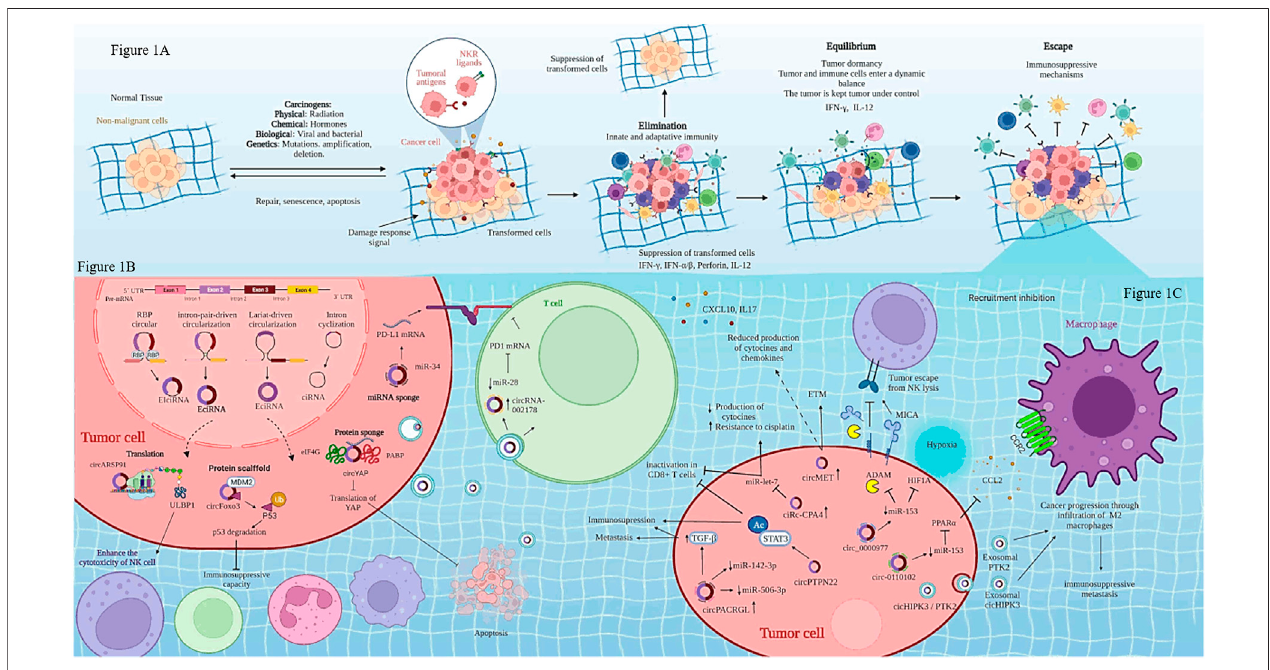
FIGURE 1 | Biogenesis of circRNAs and regulation of immune cells in cancer. (A) shows cancer immunoediting phases: elimination, equilibrium and escape. (B) Biogenesis of circRNAs is regulated by three mechanisms: lariat-driven circularization, intron pairing-driven circularization, RNA-binding proteins (RBPs)-mediated of circularization. (C) Regulation of immune cells through circRNAs-miRNAs-mRNAs interaction. Created with